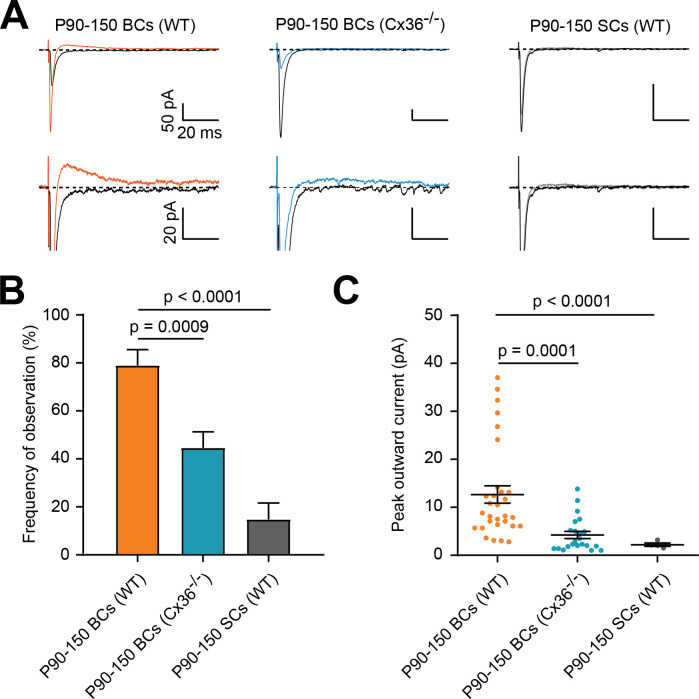
Outward currents are reduced in Cx36KO mice and stellate cells (SCs).(A) Representative traces of PF-mediated synaptic responses recorded in three different conditions (WT P90-150 BCs, P90-150 BCs in Cx36KO mice, and WT P90-150 SCs). Black and colored trace for each group are averages of 20–30 sweeps at a location without and with a detectable outward current, respectively. Bottom row is an expanded amplitude scale to better visualize outward current. (B) The frequency of observing the outward current is significantly smaller in P90-P150 SCs (WT) and BCs (Cx-36 KO), as compared to P90-P150 BCs (WT) (Brown-Forsythe with Dunnetts multiple comparisons test, F = 17.09, p<0.0001; P90-P150 BCs (WT): n = 38 stimulation sites over 11 cells, P90-P150 BCs (Cx36-/-): n = 56 sites over 14 cells, P90-P150 SCs (WT): n = 27 sites over 8 cells). (C) Outward current peak amplitude is significantly smaller in P90-P150 SCs (WT) and BCs (Cx-36 KO), as compared to P90-P150 BCs (WT) (Kruskal-Wallis test with Dunn’s multiple comparisons test, p<0.0001; P90-P150 BCs (WT): n = 30 sites over 10 cells, P90-P150 BCs (Cx36-/-): n = 22 sites over 8 cells, P90-P150 SCs (WT): n = 4 sites over 2 cells). See also Figure 2—source data 1.